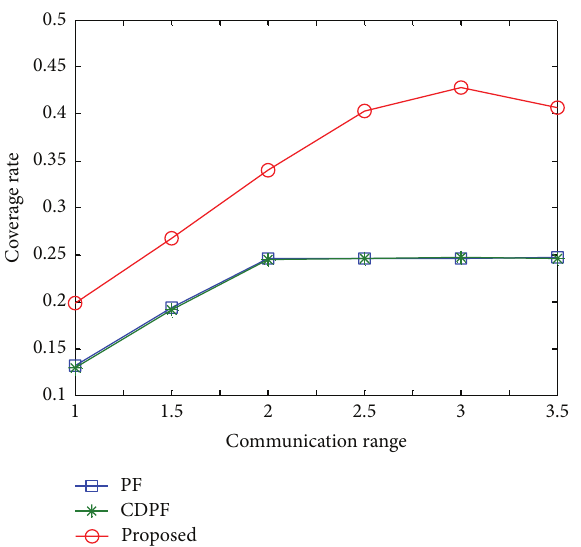
Figure 4: Coverage hole rate versus communication range (𝑟 𝑐 /𝑟 𝑠 ) .